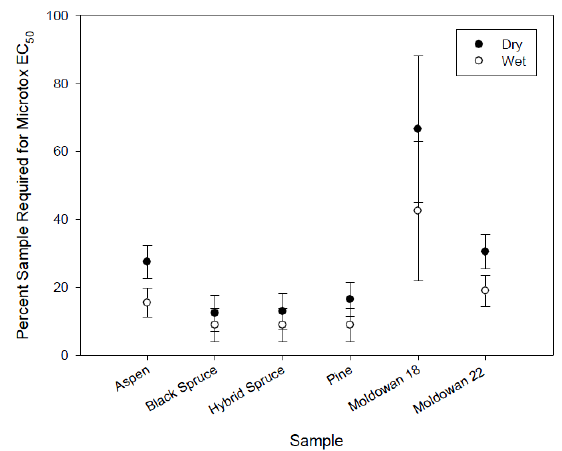
Figure 6. Microtox EC 50 mean values for rainfall simulation including standard error bars ( n = 2).